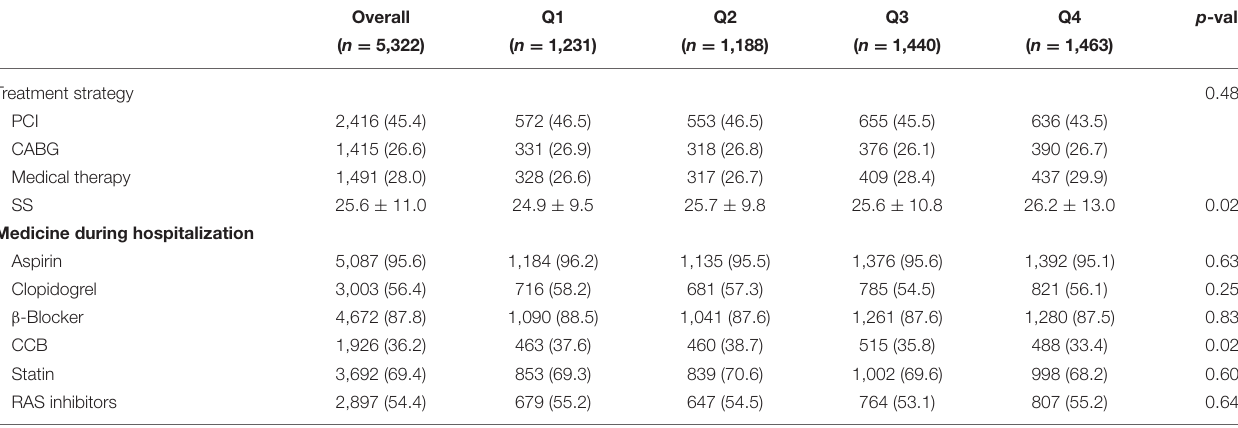
TABLE 2 | Angiographic characteristics and treatment across DB quartiles. Overall Q1 Q2 Q3 Q4